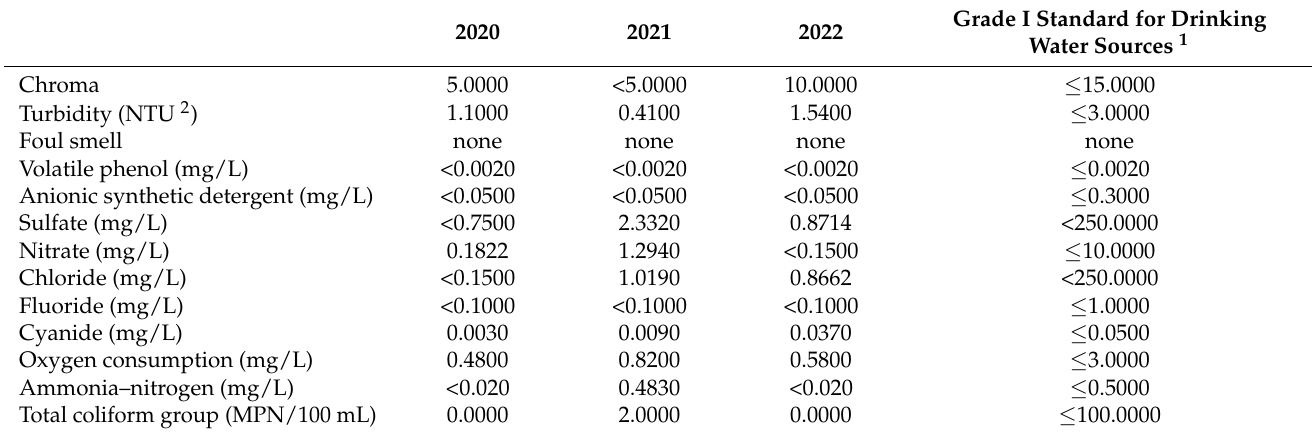
Table 1. Water quality indicators of the Carp Brook over